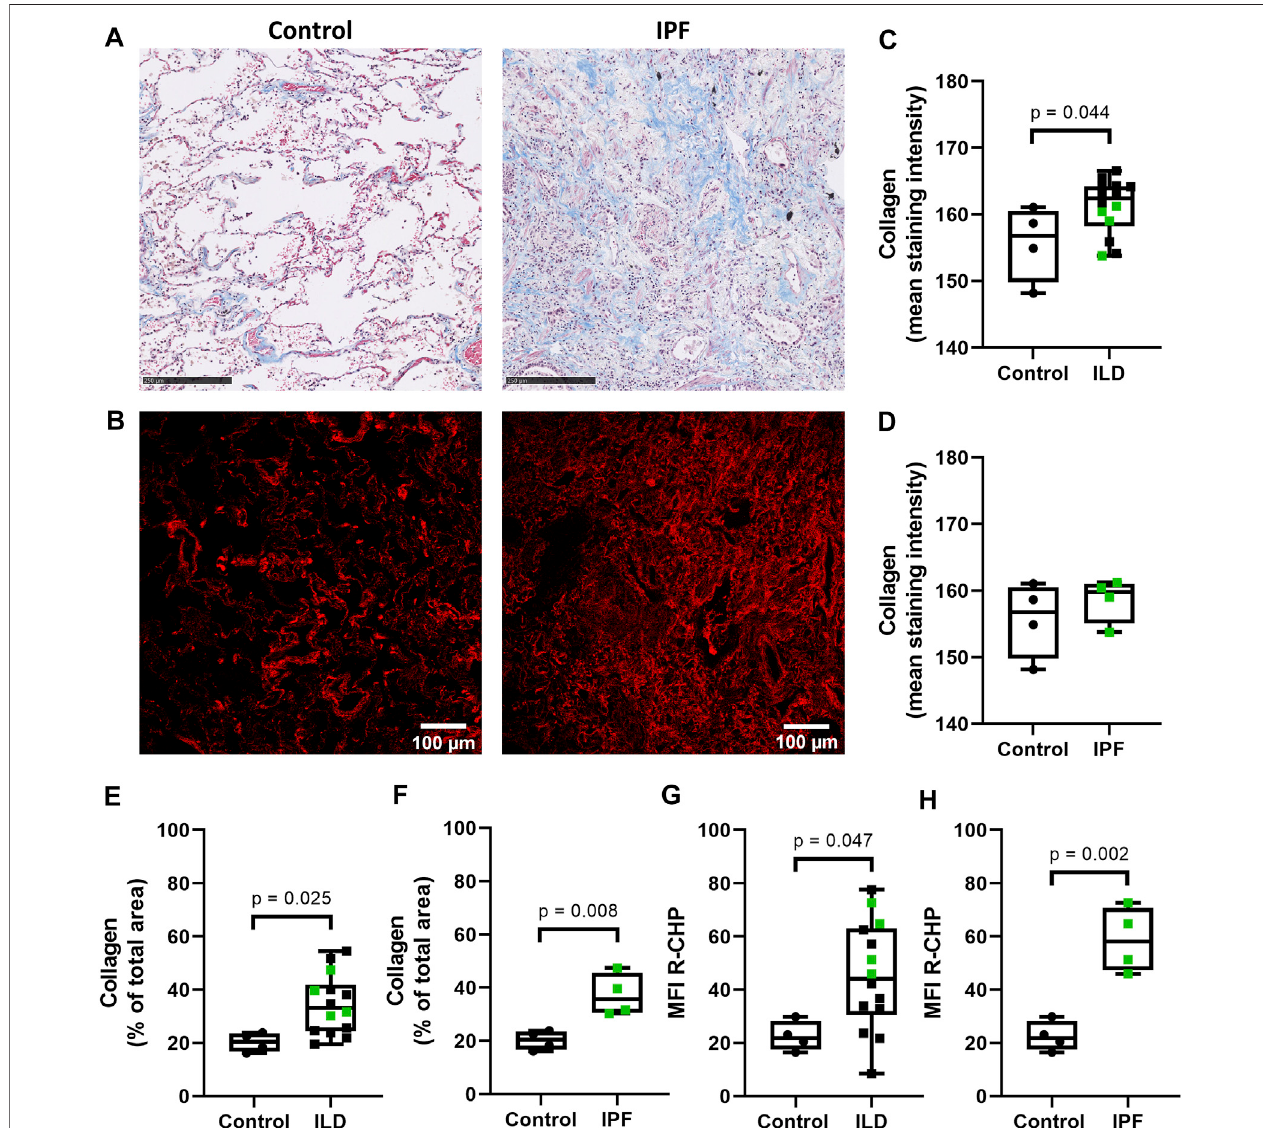
FIGURE 1 | Higher levels of denatured collagen in lung tissue from patients with IPF. Sections of lung tissue were stained using Masson ’ s trichrome stain or Cy3- conjugatedcollagenhybridizingpeptide(R-CHP). (A) RepresentativeimagesofMasson ’ strichromestainincontrollungtissue(leftpanel)andlungtissueofapatientwith idiopathic pulmonary fi brosis (IPF, right panel), showing collagen fi bers in blue and cytoplasm in red. Magni fi ed part of the whole tissue section. Scale bar (cid:2) 250 µm. (B) Representative fl uorescence images of the R-CHP signal in control lung tissue (left panel) and lung tissue of a patient with IPF (right panel), from the same patientsasin (A) . (C-F) Quanti fi cationofMasson ’ strichromestaining,showingthemeanstainingintensity (C,D) andtherelativeamountofcollageninthewholeimaging area (E,F) . Control lung tissue compared to ILD in general (C,E) , as well as speci fi cally to IPF lung tissue [ (D,F) , data from (C,E) partially repeated for visualization purposes]. (G,H) Quanti fi cationoftheR-CHPsignal,showingtheaveragemean fl uorescenceintensityofatleastthreeimagespersection.Controllungtissuecompared to ILD in general (G) , as well as speci fi cally to IPF lung tissue [ (H) , data from (G) partially repeated for visualization purposes]. One experimental replicate per subject, sample size n (cid:2) 4 (control) and n (cid:2) 14 (ILD, including 4 lung tissues from patients with IPF). Data represented as min to max box-and-whiskers plots showing all points. Groups were compared using an unpaired t -test after assessing the normal distribution with use of a QQ plot and a Shapiro-Wilk normality test ( Supplementary Figure 2A ). p < 0.05 was considered signi fi